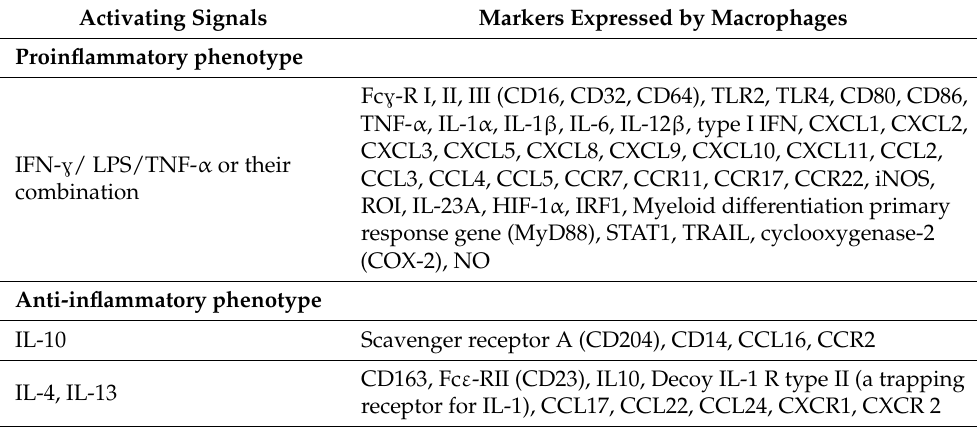
Table 1. The spectra of cytokines, chemokines, and receptors expressed by macrophages with pro- and anti-inflammatory phenotypes